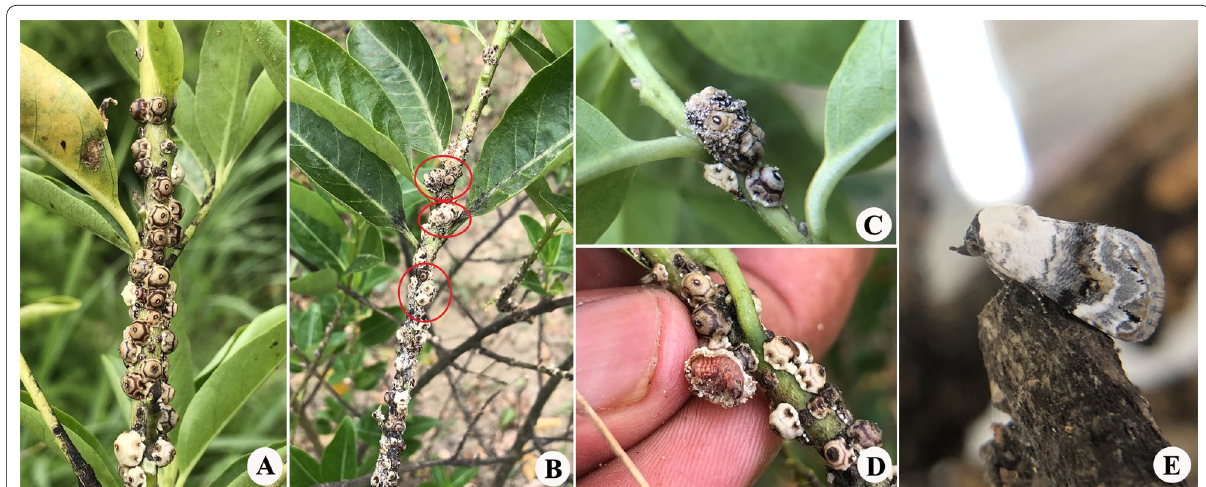
Fig. 1 a . C. cirripediformis infested shoots of C. diurnum ; b . E. scitula on C. cirripediformis infested shoots of C. diurnum ; marked with red circle in picture; c . shield-like structure formed by E. scitula by using remained scale cells of C. cirripediformis ; d . larva of E. scitula inside the shield-like structure; e . adult moth of E.